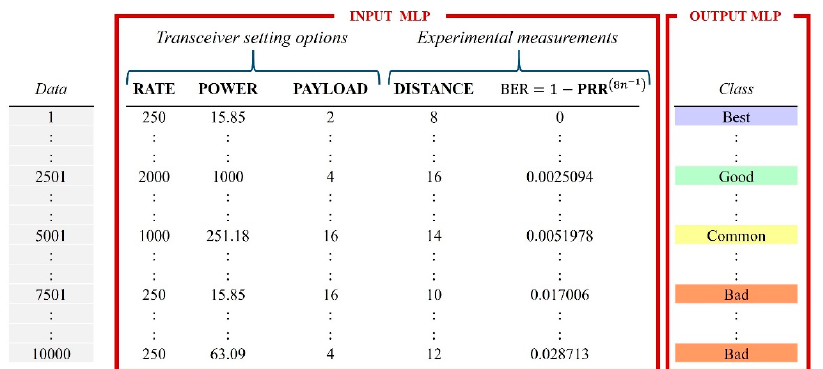
Figure 6. Dataset structure from CSV file.